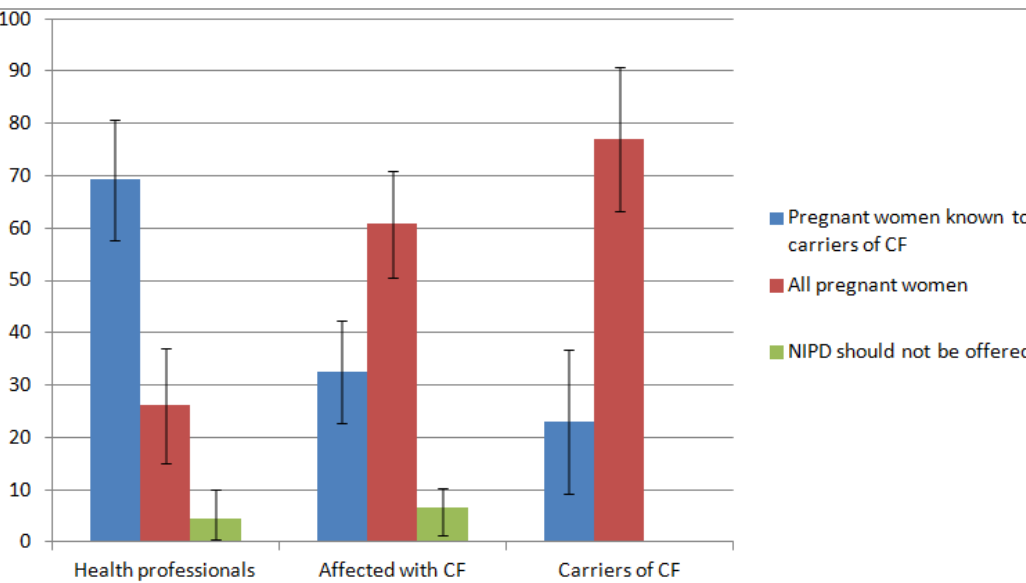
Figure 1. Who should be offered NIPD for